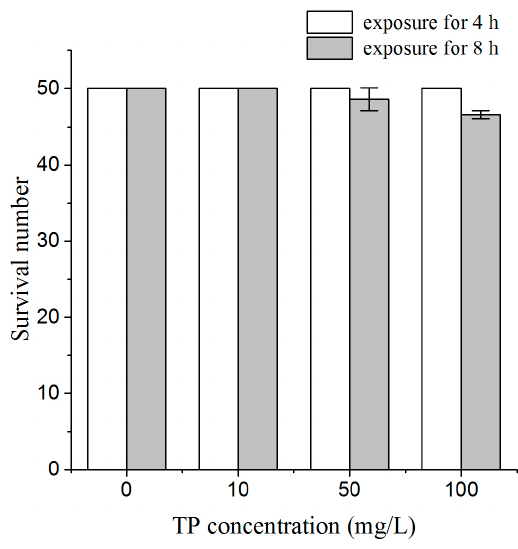
Figure 1. Survival of nematodes exposed to TP for 4 and 8 h. TP, Triptolide. Note: There are no error bars for the control and 10 mg/L Triptolide groups because there were no dead nematodes in the three repeated experiments.